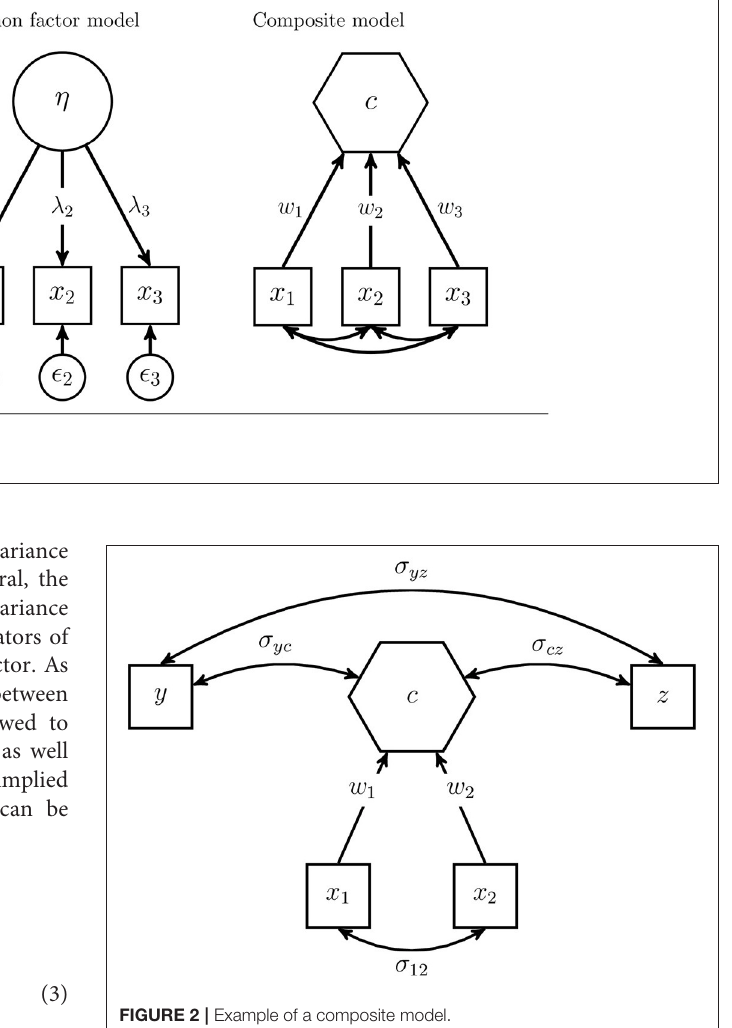
FIGURE 2 | Example of a composite